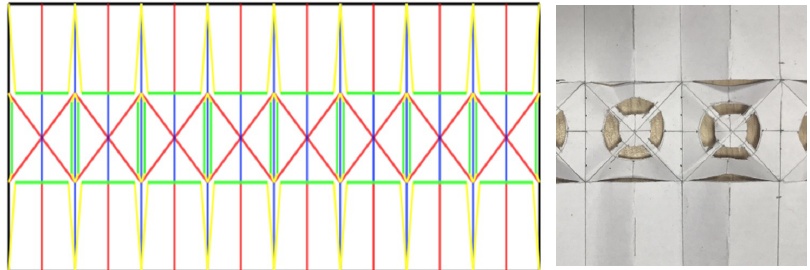
Figure 1. Schematic representation ( left ) and a section of the actual prototype ( right ) of the pop-up kirigami structure. The lines in the schematic denote the following: red lines—mountain fold, blue lines—valley fold, green lines—cuts. The structure buckles under a compressive force to project the center platform up.